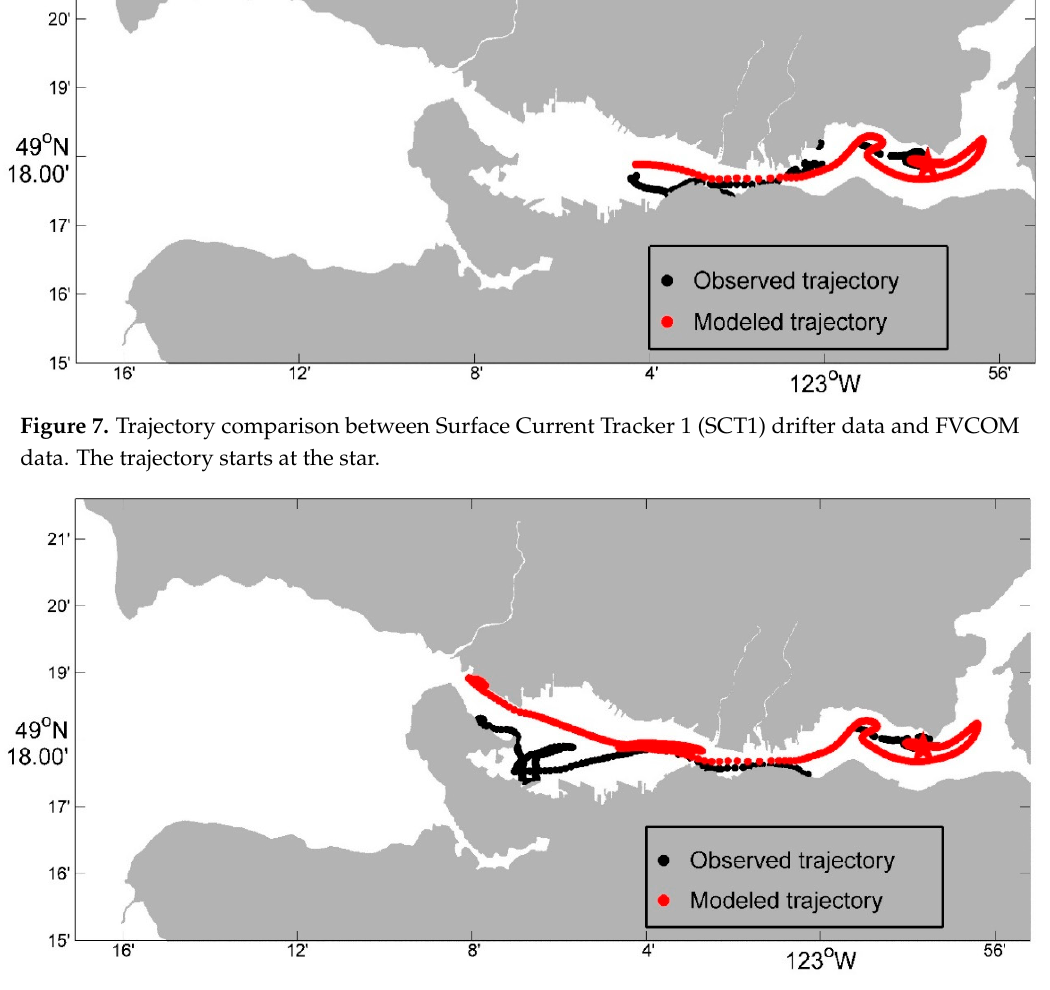
Figure 8. Trajectory comparison between SCT2 drifter data and FVCOM data. The trajectory starts at the star.